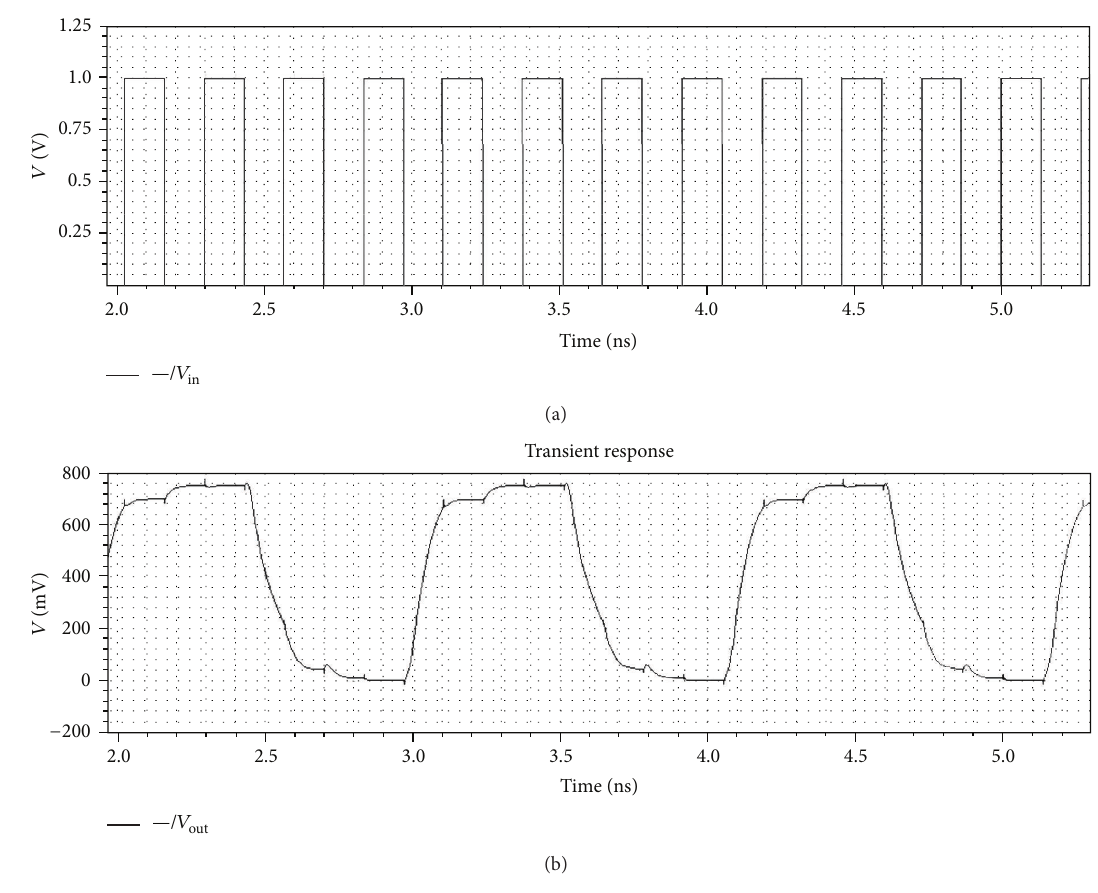
Figure 5: Square wave input at 3.7GHz and resulting output.